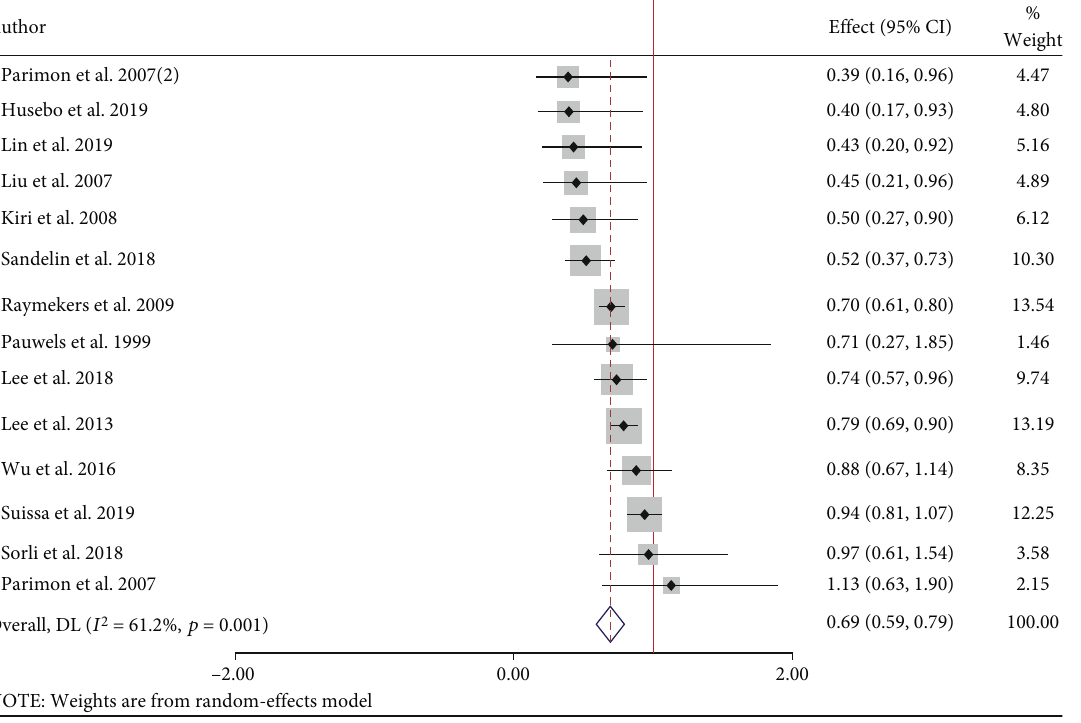
Figure 2: Forest plot of pooled HR of ICS use in COPD patients and the risk of lung cancer. Table 2: Subgroup analysis of the pooled HR of ICS use in COPD patients and the risk of lung cancer.